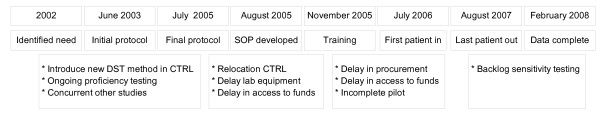
Time line and constraints drug resistance survey Tanzania.